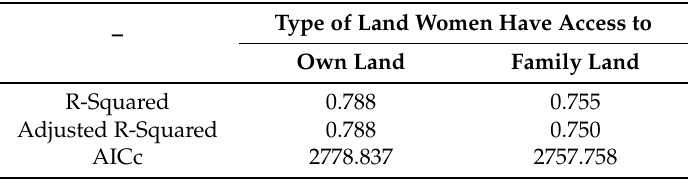
Table 2. Summary of GWR diagnostic